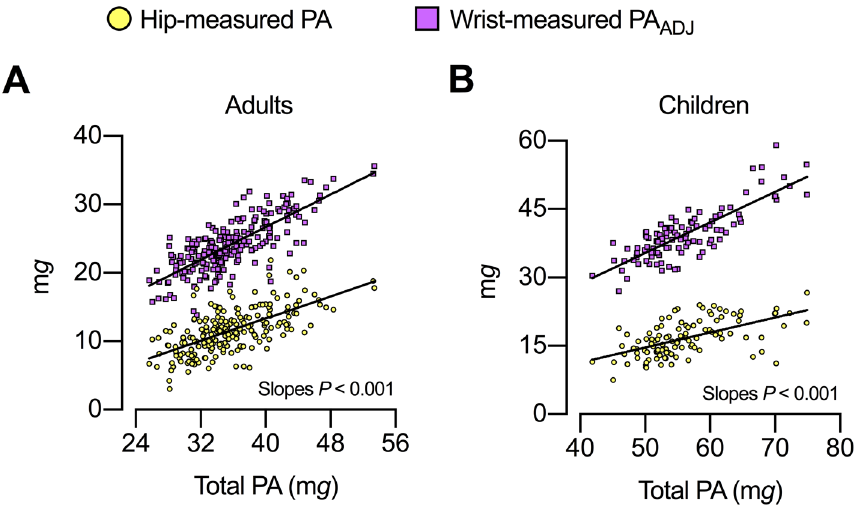
Figure 3. Association between total physical activity [PA] and its components in ( A ) adults and ( B ) children. Wrist-measured PA ADJ represents wrist-measured PA adjusted for hip-measured PA. Adults n = 209; children n = 105.